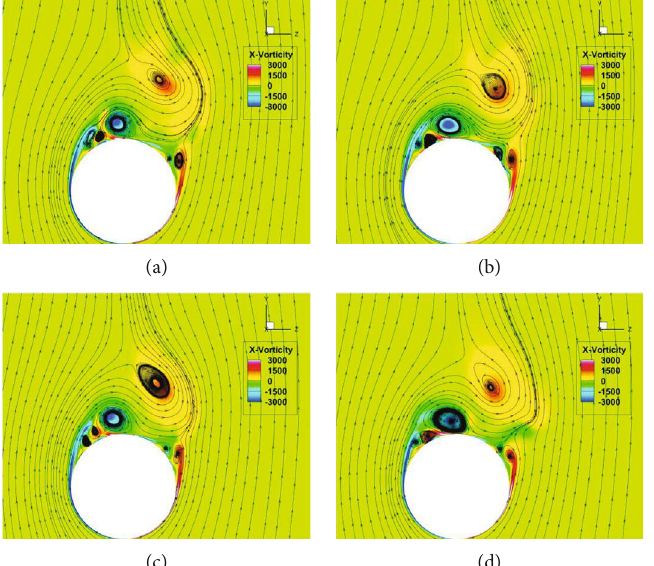
Figure 20: Contrast contour of X -vorticity with di ff erent roughness values at section 3: (a) Model 1, (b) Model 2, (c) Model 3, and (d) Model